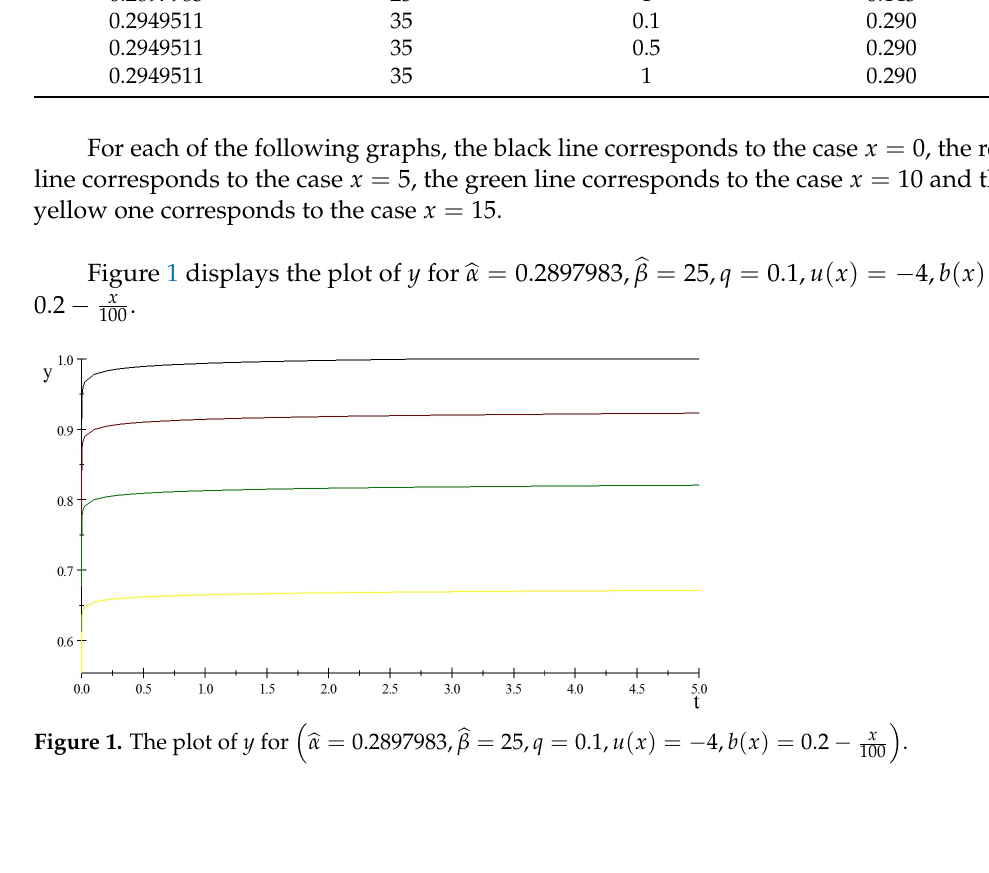
Figure 1. The plot of y for